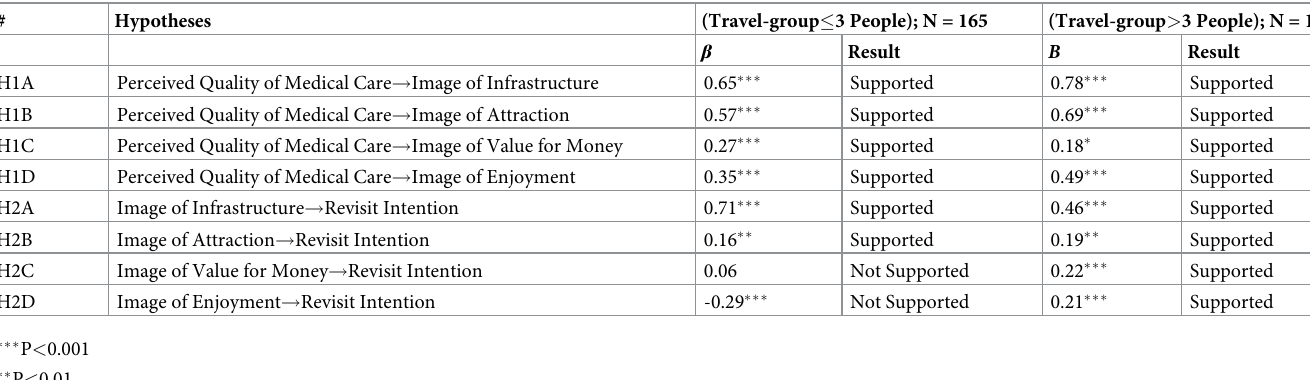
Table 7. Path analysis results—Travel-group.